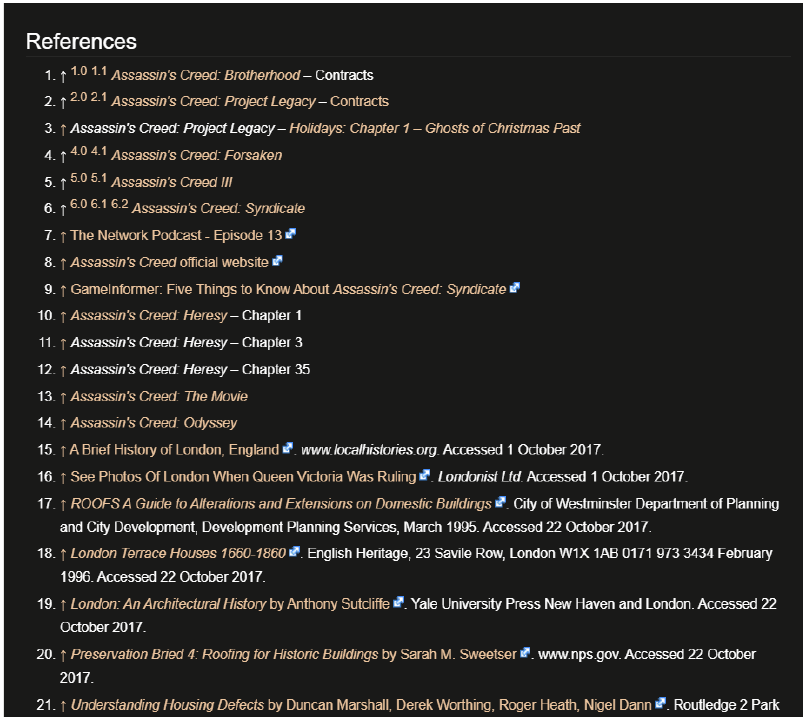
Figure 14: A screenshot of the list of references for the London article in the Wikia for Assassin's Creed Syndicate